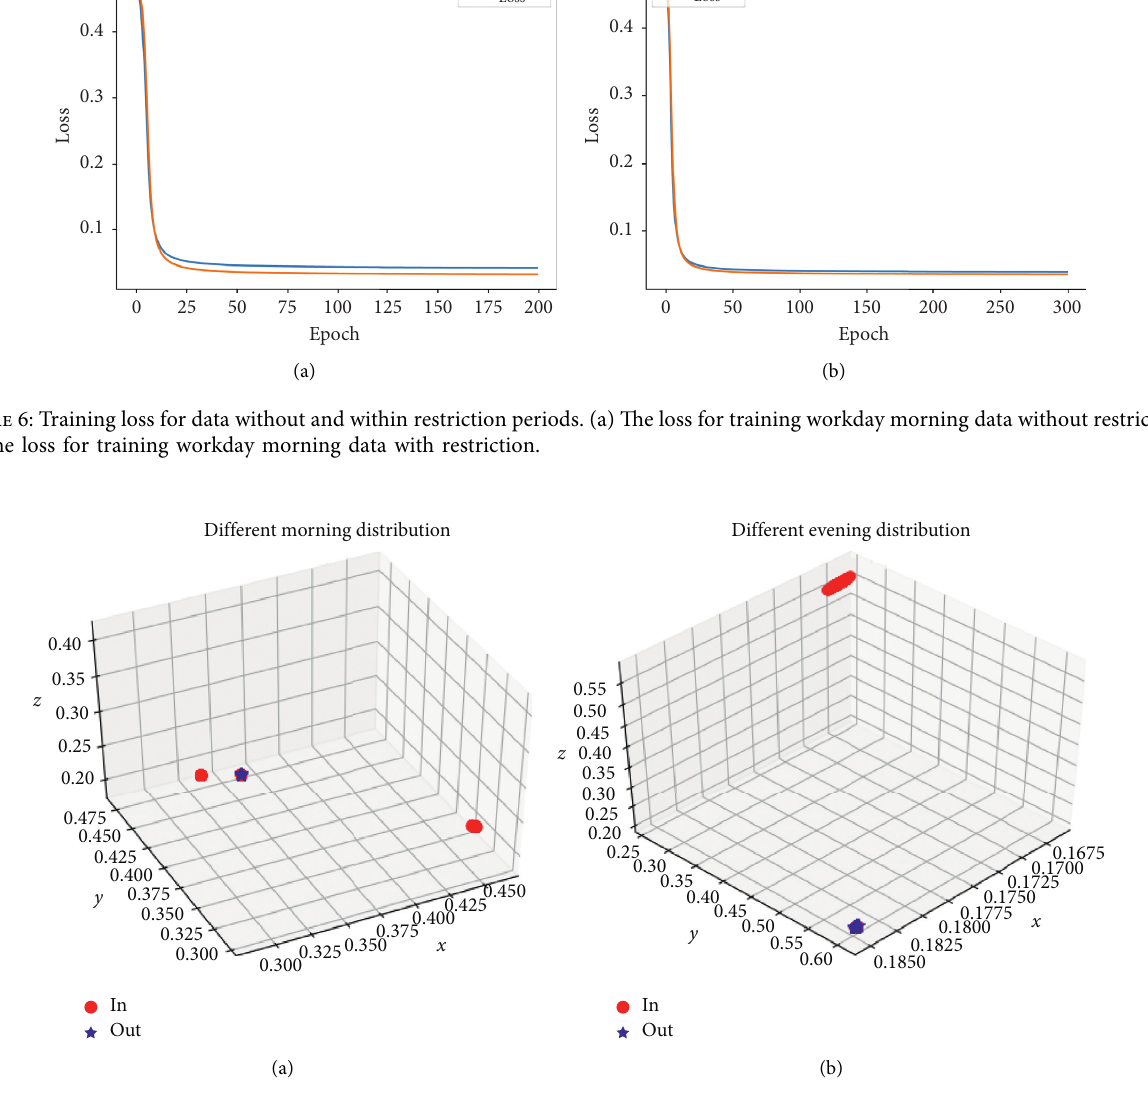
Figure 7: Vectors captured by the proposed stacked convolutional autoencoder. The latent space features are three dimensions. Vectors are divided into four categories, morning and evening peak hours and in and out of the restriction period. Scatter plots are organized by peak hours: (a) morning peak hours and (b) evening peak hours. The red circle marker is vector in the restriction period, and the blue star marker is vector out of the restriction